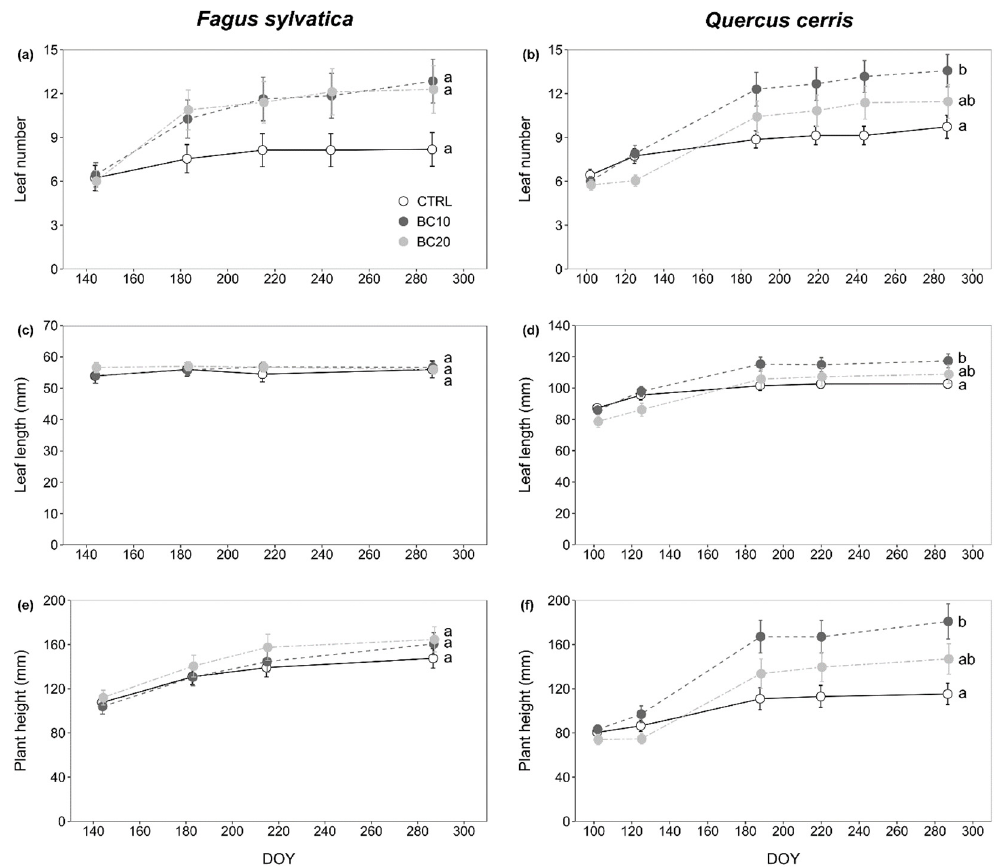
Figure 1. Morphometric parameters (mean ± standard error) over time (day of year, DOY) for Fagus sylvatica ( a , c , e ) and Quercus cerris ( b , d , f ) grown in soils amended with 0% (CTRL), 10% (BC10), and 20% (BC20); different letters indicate statistically significant differences between treatments ( p < 0.05).